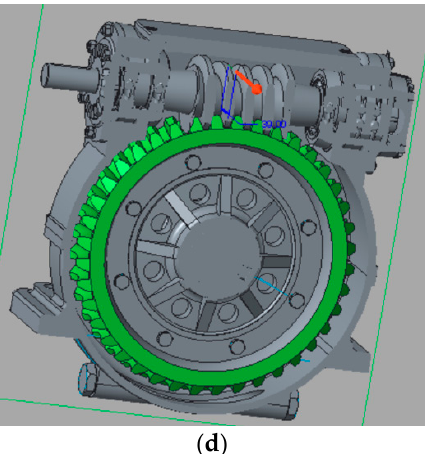
Figure 1. ( a ) 2D drawing of the gearbox with warm screw (staring point of the process). ( b ) Entire assembly. ( c ) Transversal section. ( d ) Longitudinal section. ( b – d ) Screw-helical wheel pair; 2D drawings taken from Straneo Consorti et al. [11] and 3D modeled.